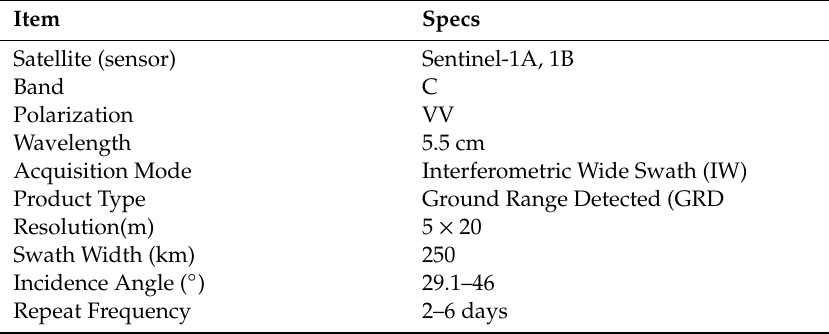
Table 1. Data Source Technical Specifications.